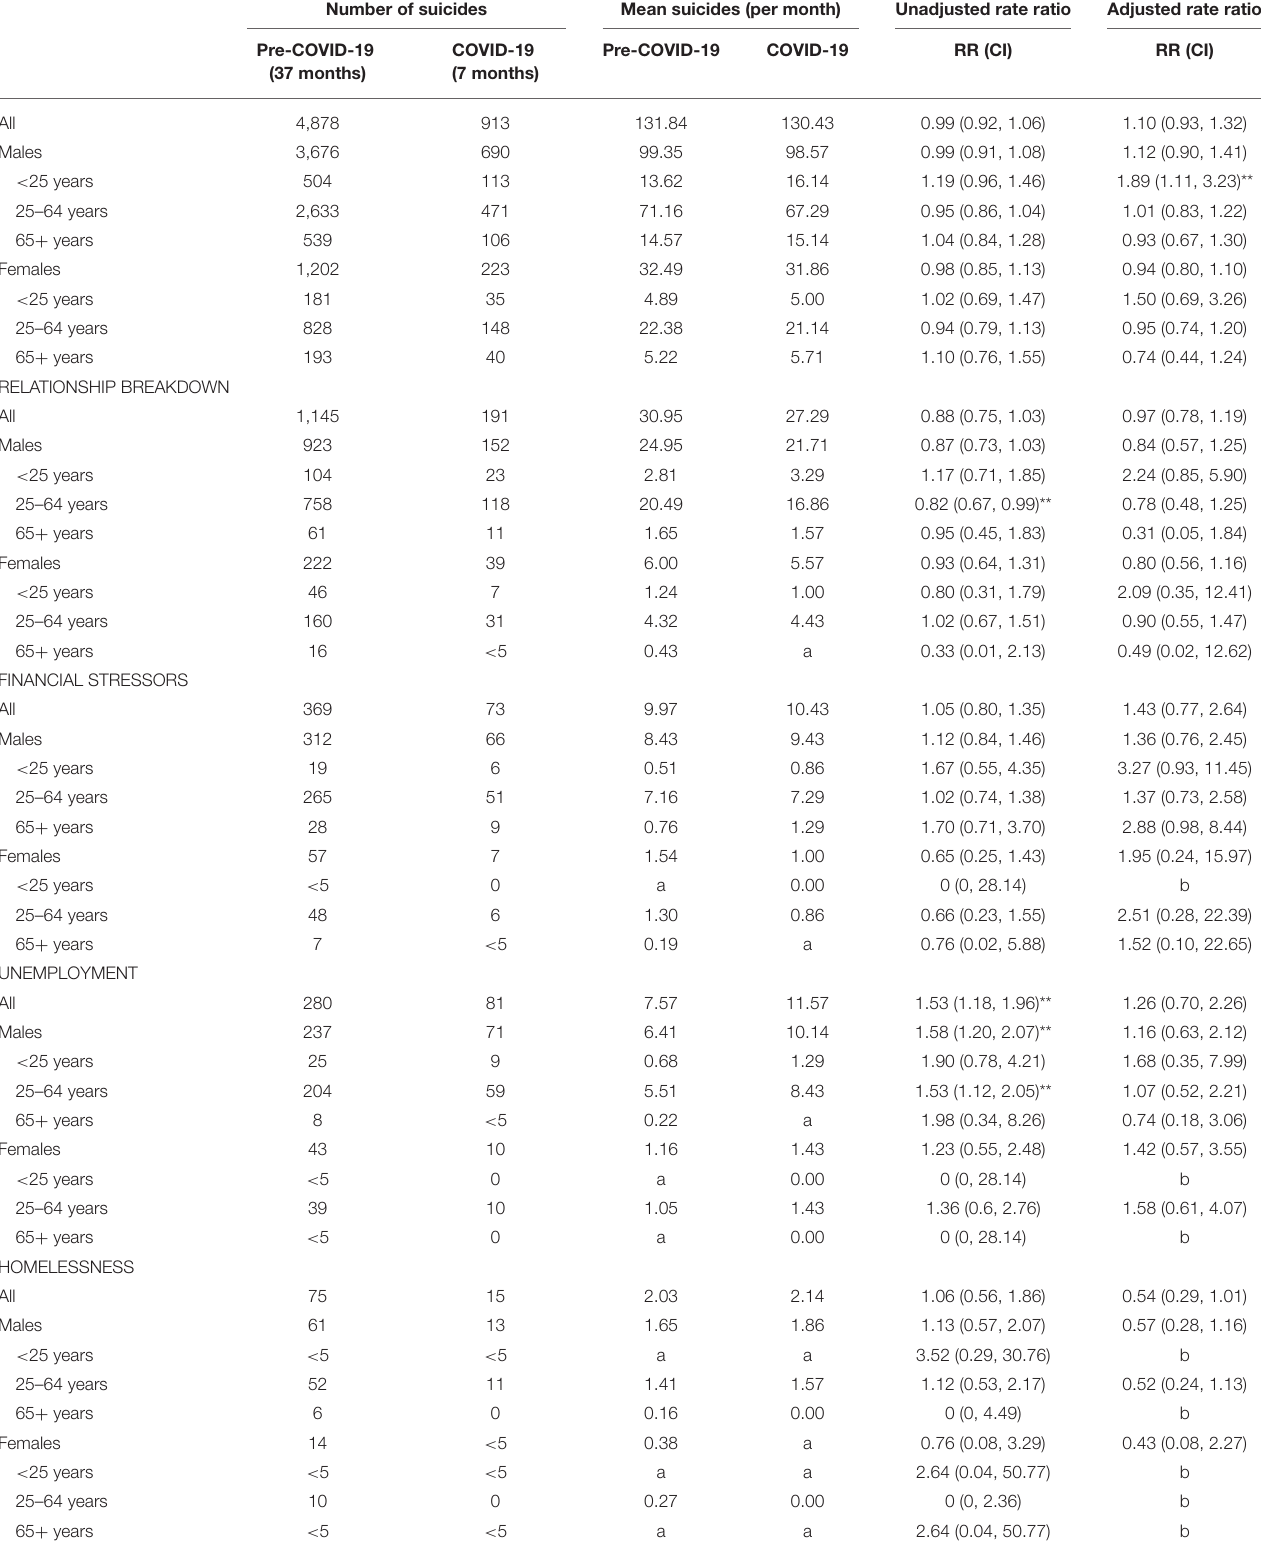
TABLE 3 | Unadjusted and adjusted rate ratios of suspected suicides in the COVID-19 period based on the trends in the pre-COVID-19